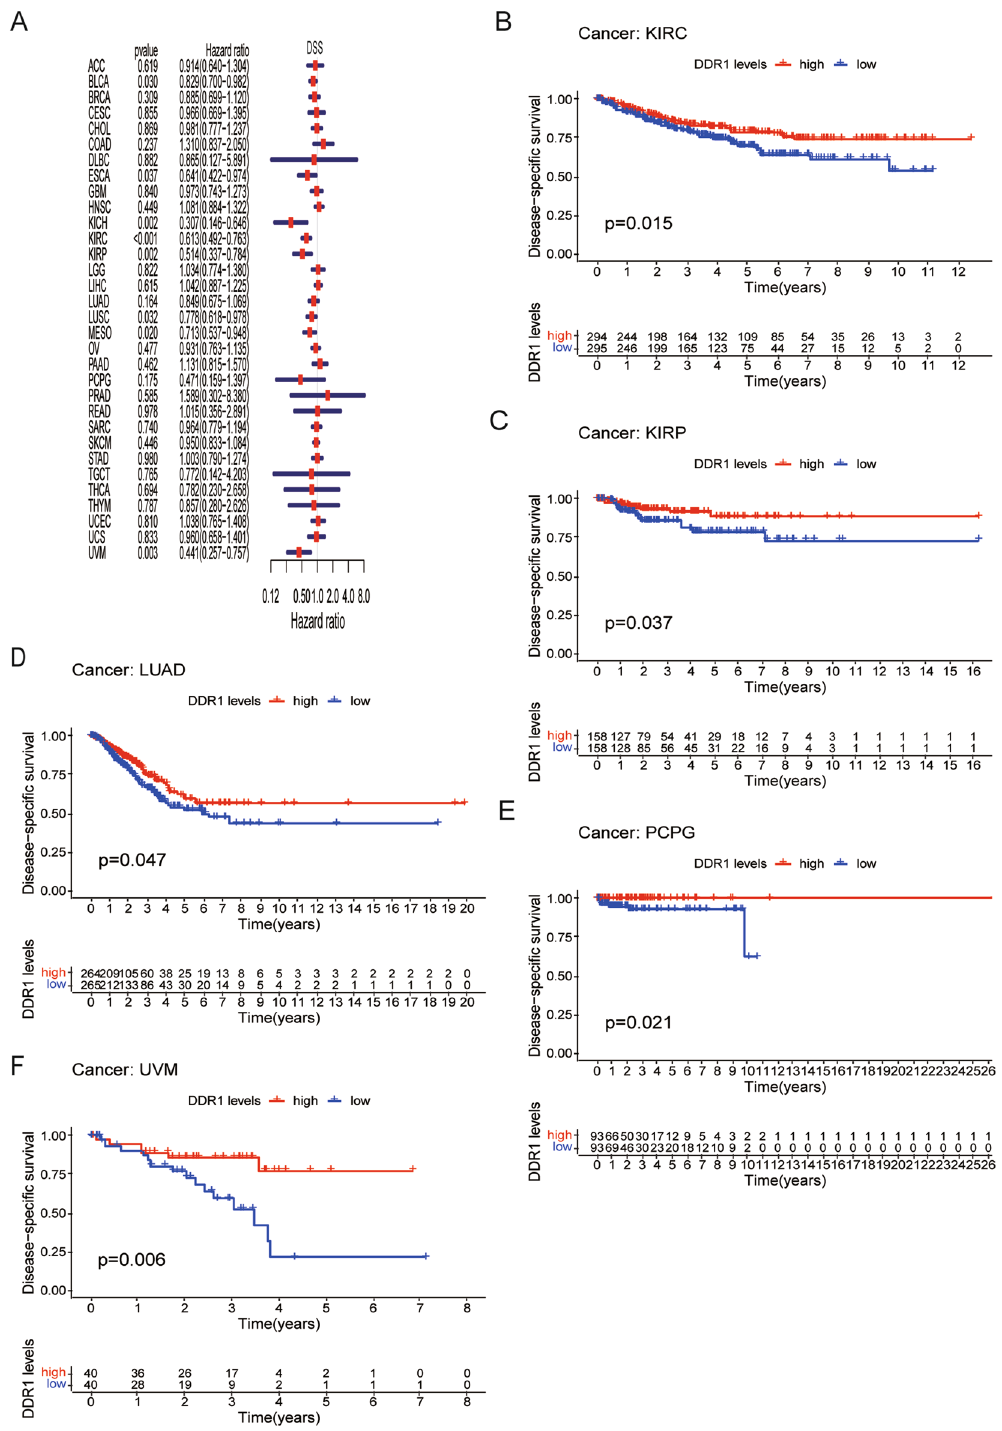
Figure 4. Association between DDR1 expression and disease-specific survival (DSS). ( A ) Forest plot shows the univariate Cox regression results for the association between DDR1 expression and DSS in 33 types of tumors. ( B–F ) Kaplan–Meier analysis of the association between DDR1 expression and